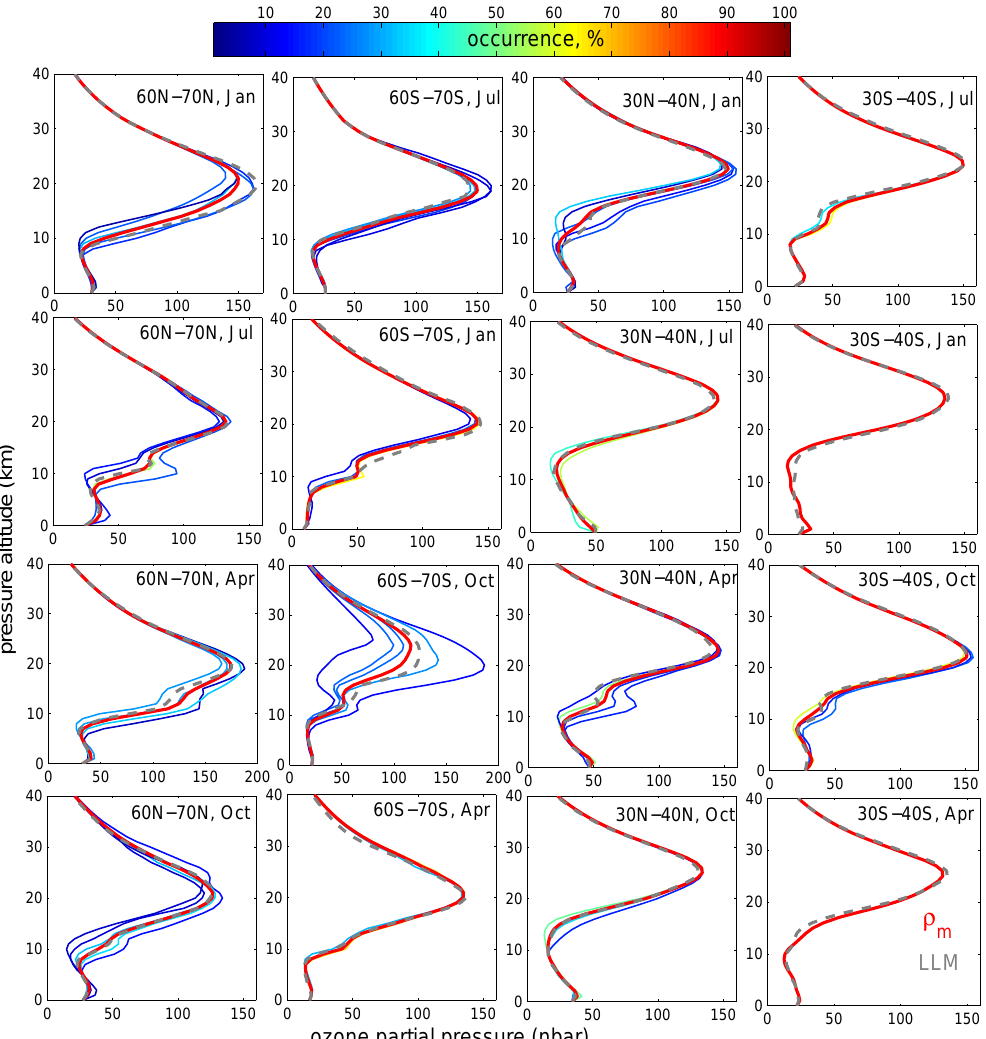
Fig. 9. Comparison of the TpO 3 climatology with the LLM climatology, for selected latitude bands and months. Thin colored lines: profiles from TpO 3 climatology; color indicates the probability distribution (frequency of occurrence) of the corresponding tropopause height. Red thick lines are the